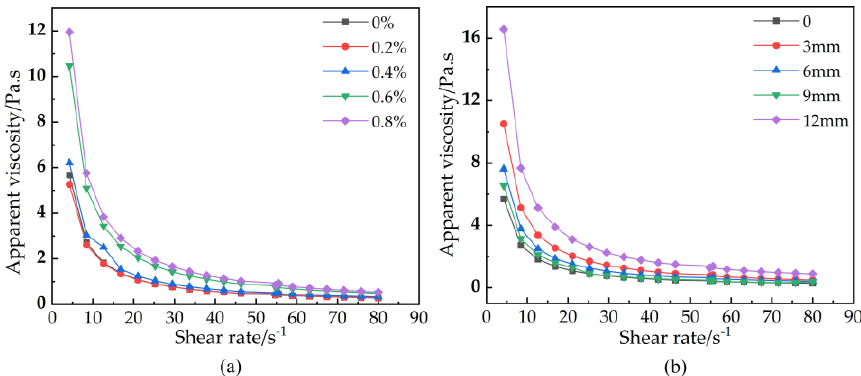
Figure 4. The relationship between shear rate and apparent viscosity: ( a ) fiber content; ( b ) fiber length.